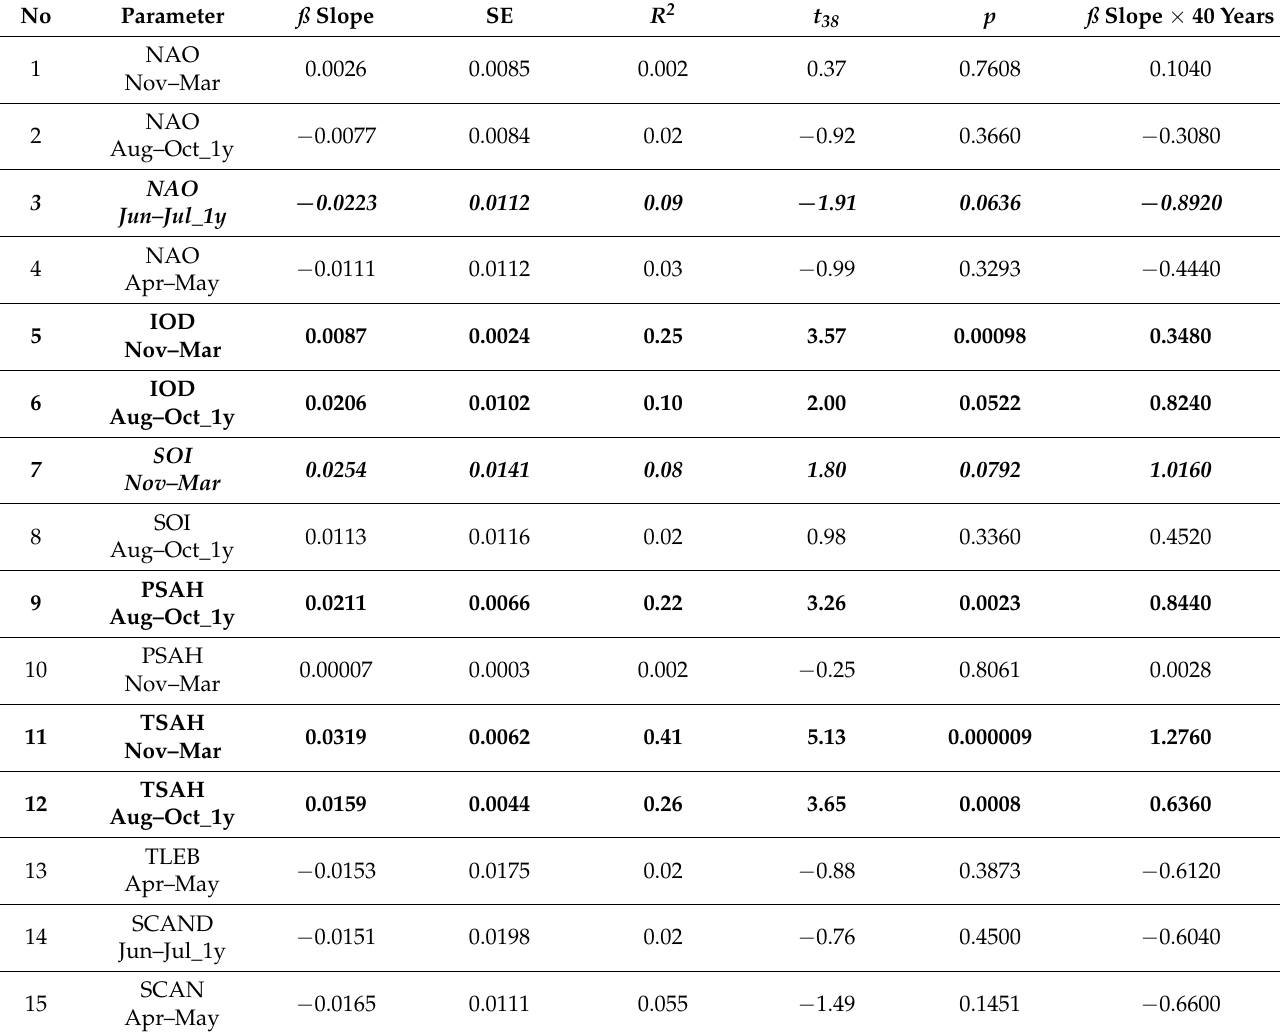
Table A2. Summary statistics for linear regressions over the year in 1982–2021 for the climate variables used in the study (Figure 5). June–July and August–October means are averages in 1981–2020 for the season preceding the spring migrations in 1982–2021. Values averaged for the given range of months and used as raw (non-standardised) data. Abbreviations of variables as in Table 1. p < 0.05 marked in 1982–2021, negative values reflect earlier